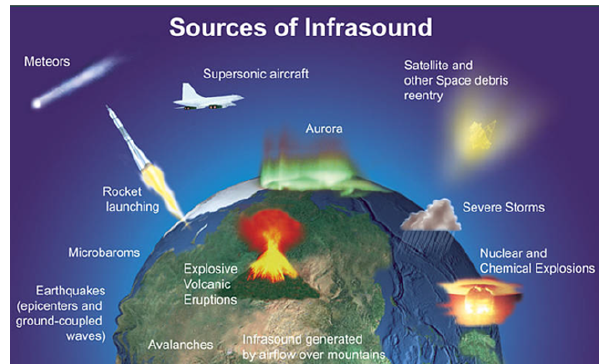
Figure 1. Sources of infrasound, both artificial and naturally occur- ring, from the ARISE website (http://arise-project.eu/, last access: 2017).